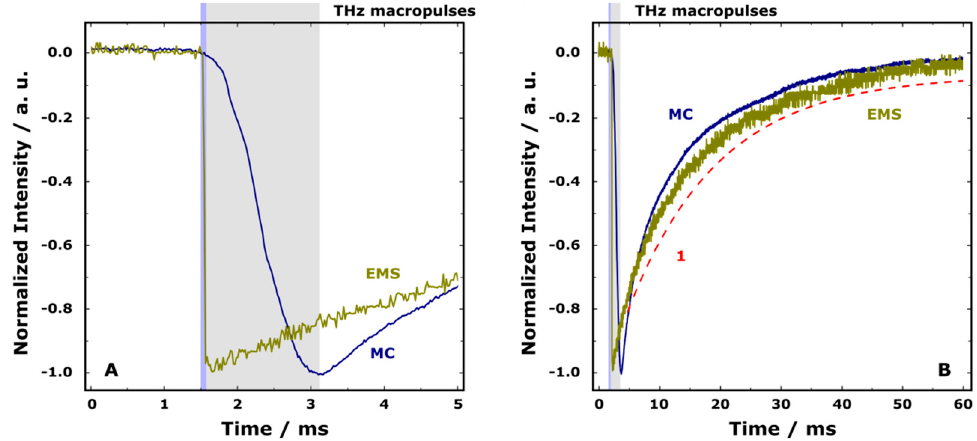
Figure 8. ( A ) Comparison of the initial parts of normalized TR EPR kinetics of I at 360 mT obtained by the electronic modulation system (EMS) and mechanical optical chopper (MC, see reference [3] for details) using typical pulse lengths for these two approaches of radiation modulation. Blue and gray rectangles schematically show THz macropulse lengths for EMS and MC, respectively. Experimental parameters are given in the Figure 7 caption. ( B ) The same as A at different timescale. Curve (1) shows one-exponential fit (vertically shifted) of the TR EPR kinetics obtained by EMS. The characteristic time is 15 ms.